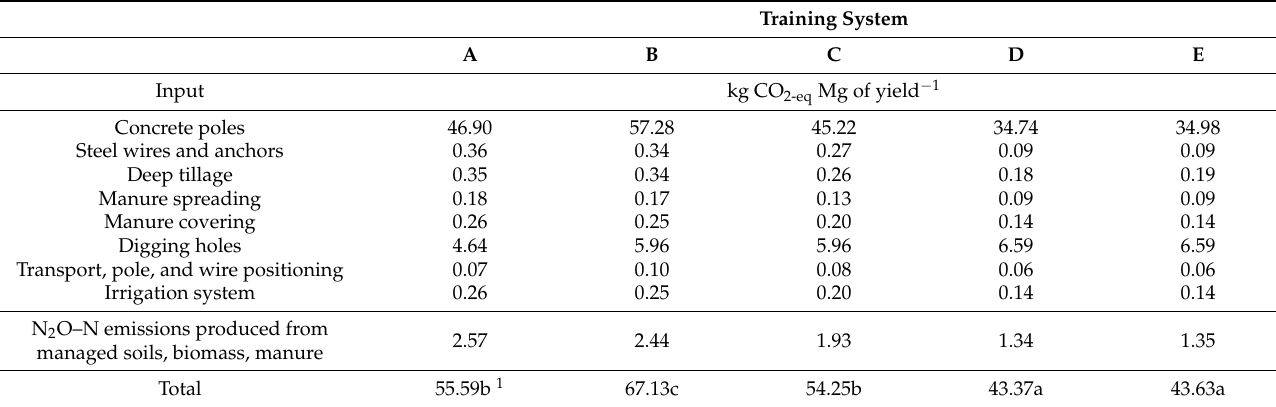
Table 8. Table GHG emissions associated with vineyard planting calculated for 1 Mg of yield; values of GHG emission have been spread over the period 2001–2020 (kg CO 2-eq Mg of yield − 1